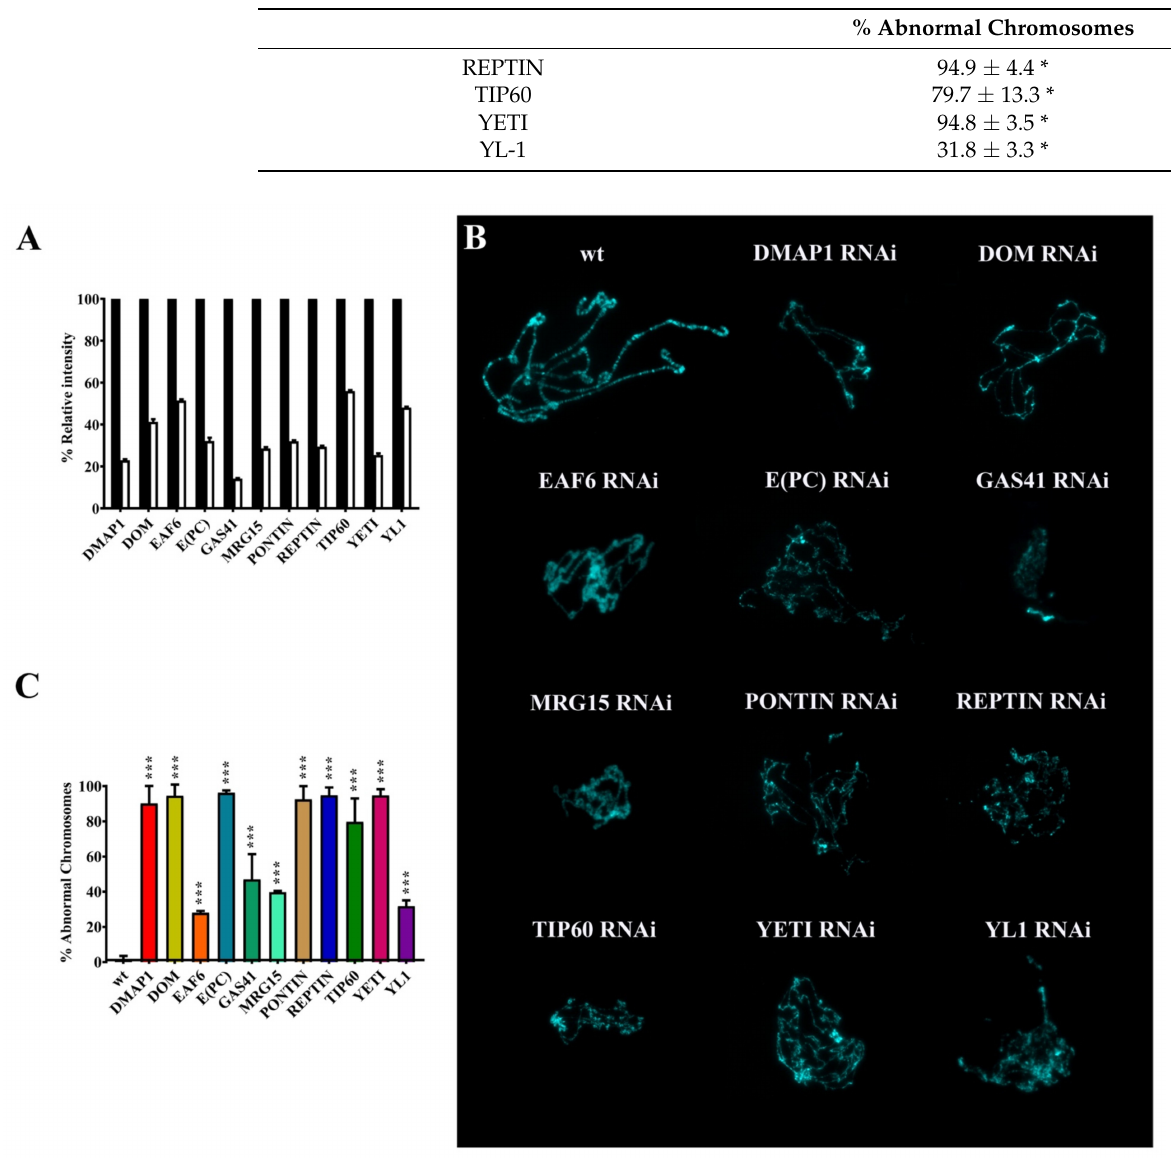
Figure 3. Polytene chromosome defects after silencing of genes coding for dTip60 complex subunits. ( A ) Semi-quantitative PCR of RNA extracted from salivary glands showed significant silencing of the genes encoding the subunits of interest. ( B ) Examples of salivary gland polytene chromosome defects. ( C ) Quantification of polytene chromosome defects. p value <0.0005 (***), compared with the control